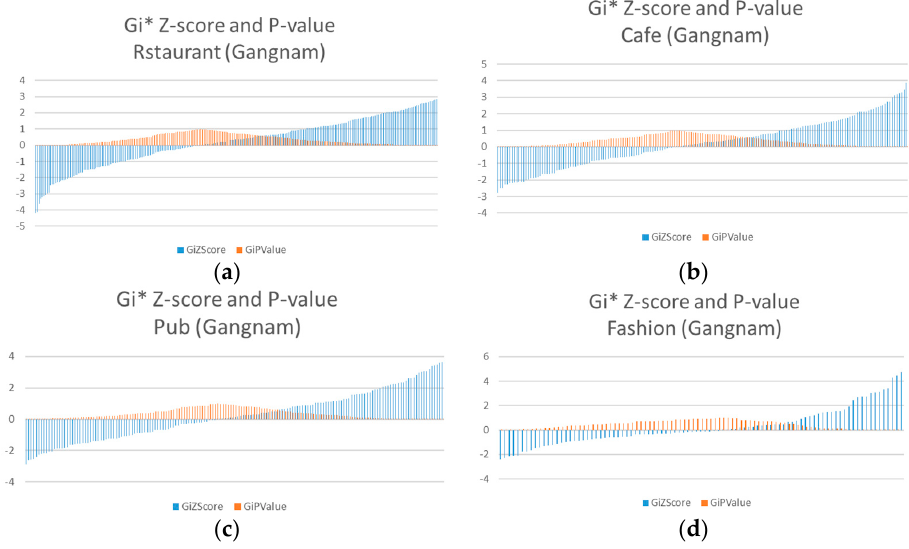
Figure 13. (cid:1833) (cid:3036)∗ z-score and p-value of road segments of each themes in Gangnam test area: ( a ) Figure 14. G ˚ z-score and p -value of road segments of each themes in Gangnam test area: ( a ) restaurant; i restaurant; ( b ) café; ( c ) fashion; ( d ) pub. ( b ) café; ( c ) fashion; ( d ) pub.